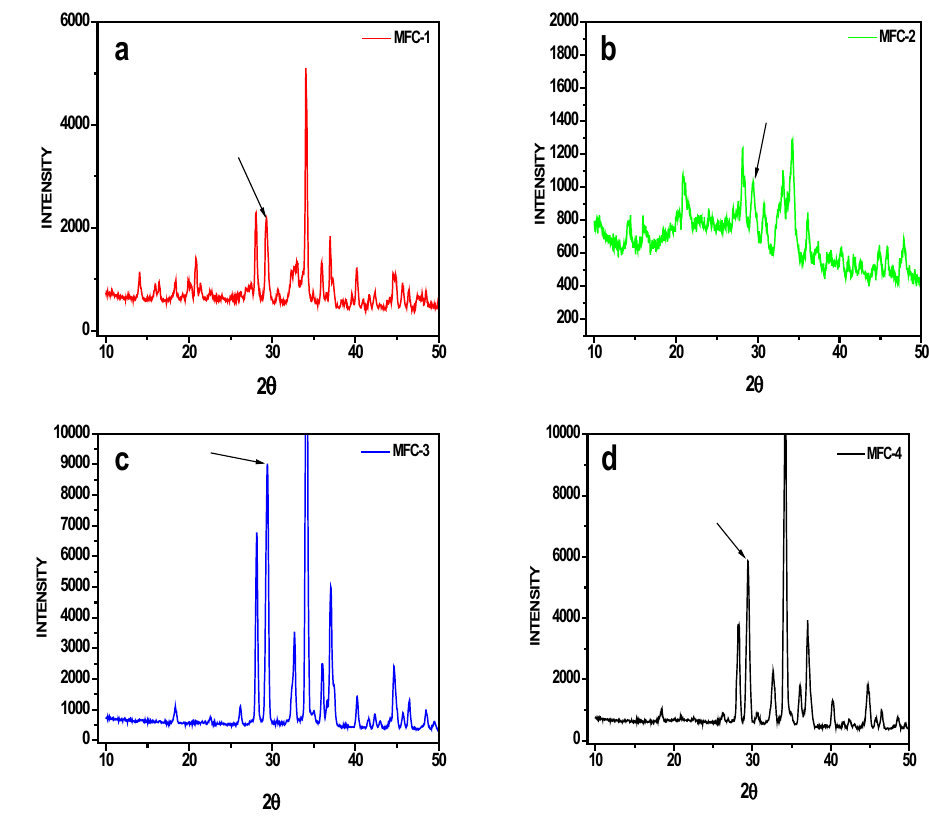
Fig. 8 XRD analysis of the outer scrapped cathode material for a MFC-1, b MFC-2, c MFC- 3, d MFC-4,